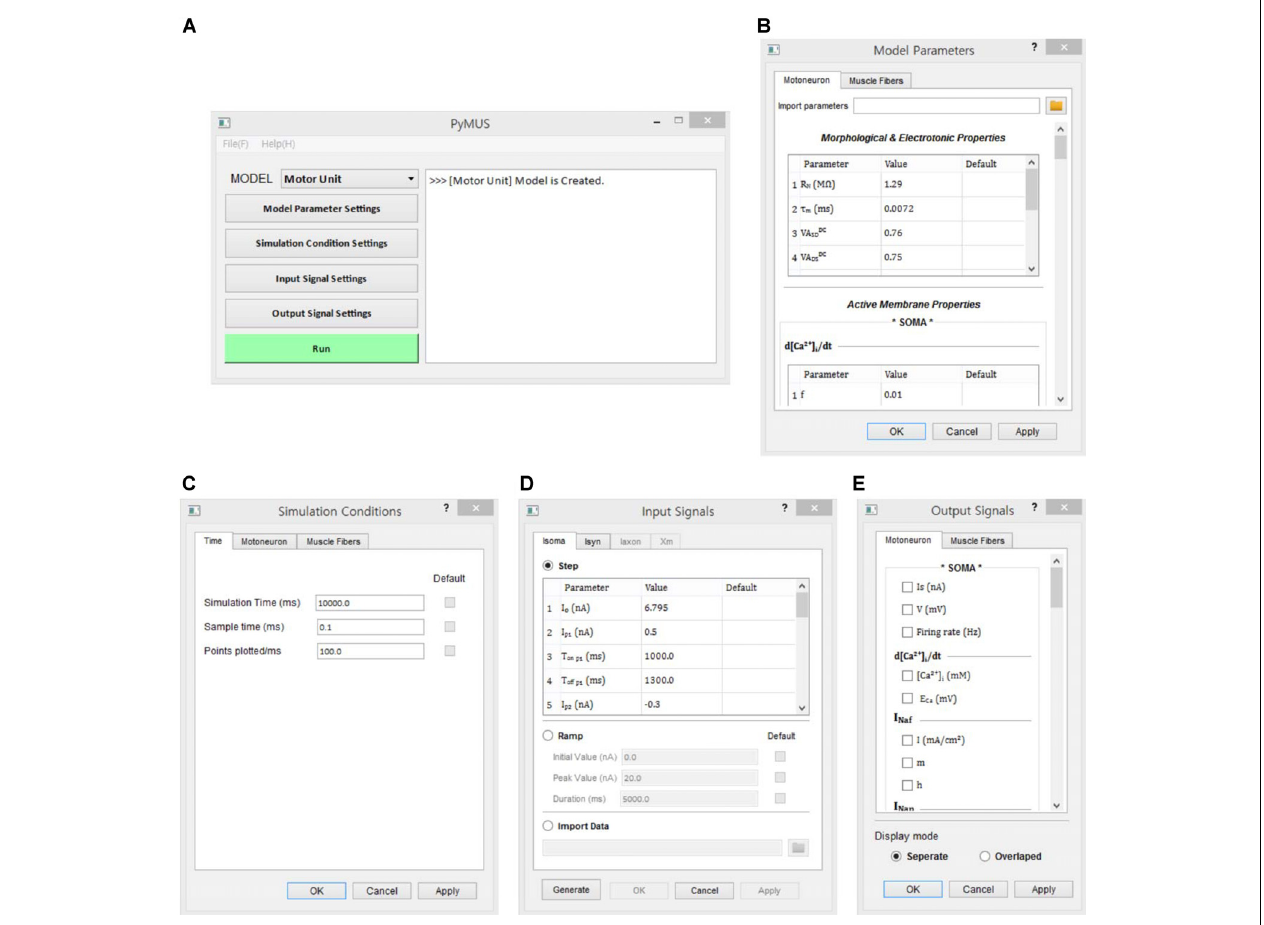
FIGURE 3 | Graphical user interfaces for PyMUS. The main window (A) provides all graphical user interfaces for the model selection (A) , model parameter setup (B) , simulation condition setup (C) , input signal setup (D) , output signal setup for display of simulation results (E)